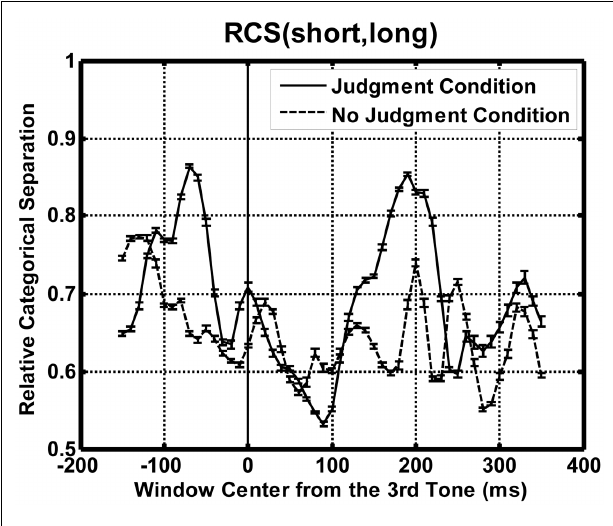
FIGURE 9 |Time course of the mean square of the difference waveforms between the selective averages for the equal and the unequal response trials, across recording sites for t 1 = 280ms. Moving average was calculated using a 100-ms square-shaped time window. Solid vertical lines indicate the timings of the three tones. Error bars represent the SE across the participants ( N =